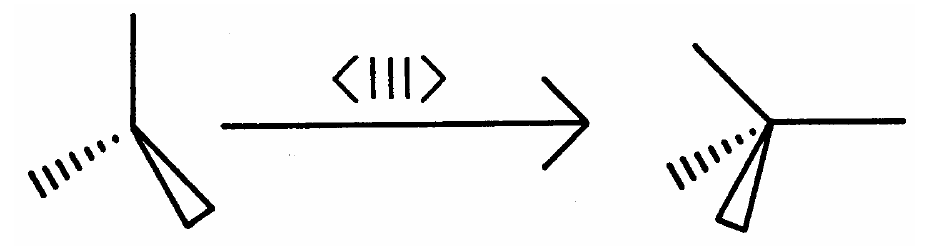
Figure 5. Cubic symmetry preserving distortion of trigonal planar vertex into tetrahedral